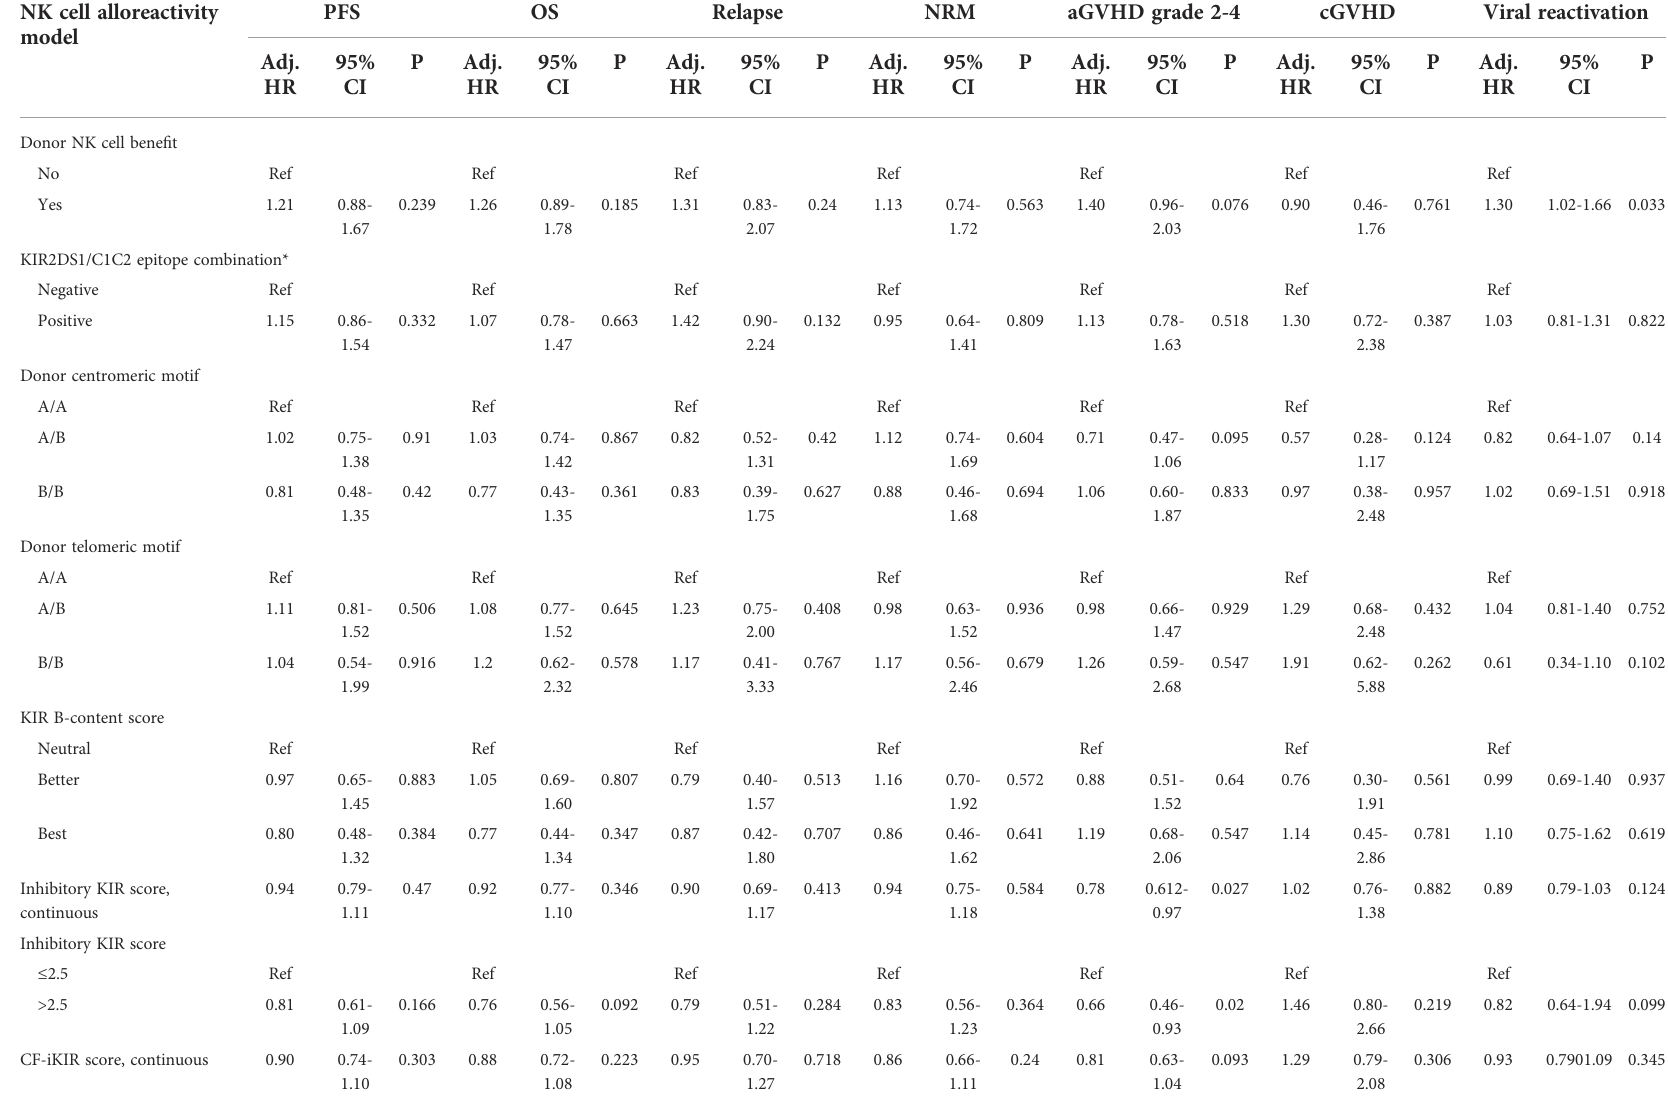
TABLE 3 Multivariable analysis of the effect of NK cell alloreactivity predicted by different models on haploidentical HSCT outcomes in our cohort (n = 354). NK cell alloreactivity